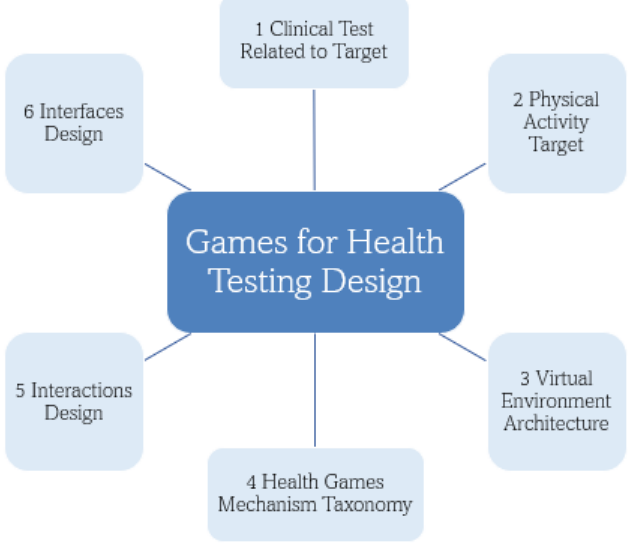
Figure 2. Critical items to consider when designing tests for games for health.